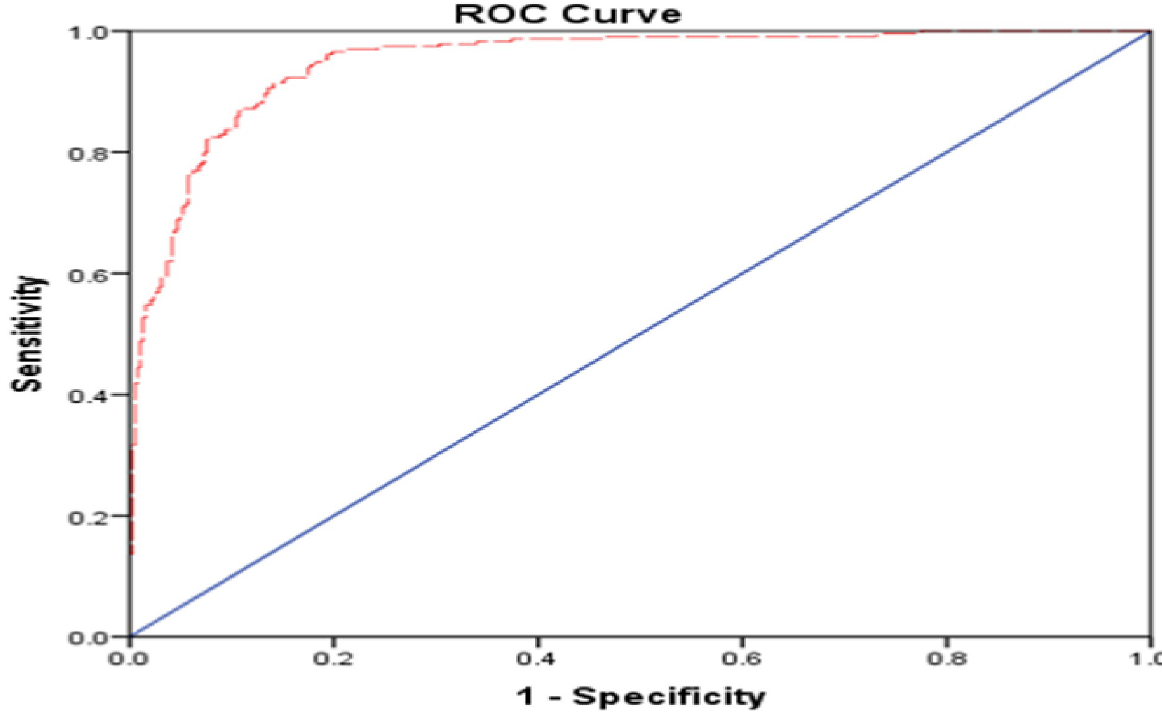
Fig 2. Receiver operating characteristics curve for the fitted model.